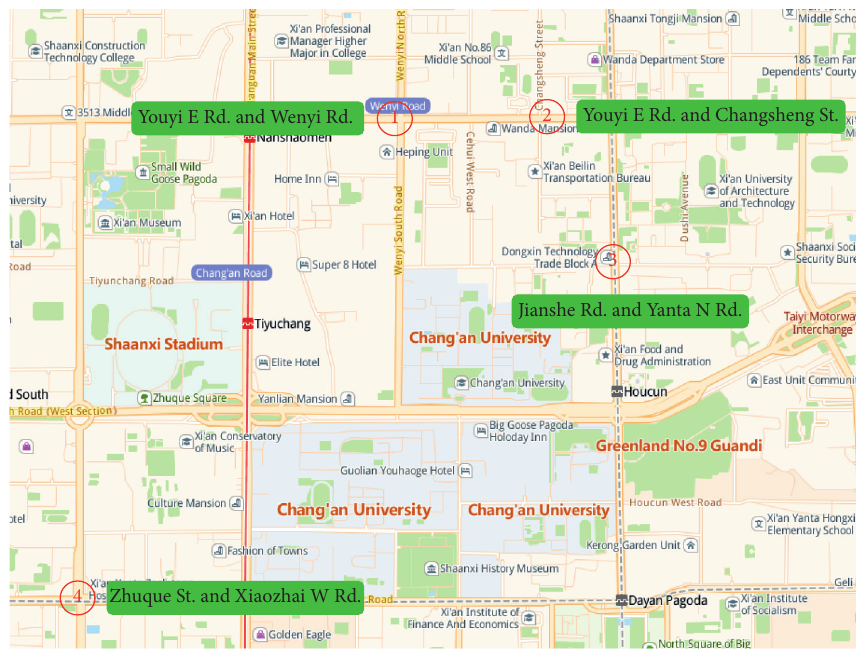
Figure 2: Field survey locations in the Xi’an city (the geographical background comes from AutoNavi). Table 1: Intersection for field data collection.